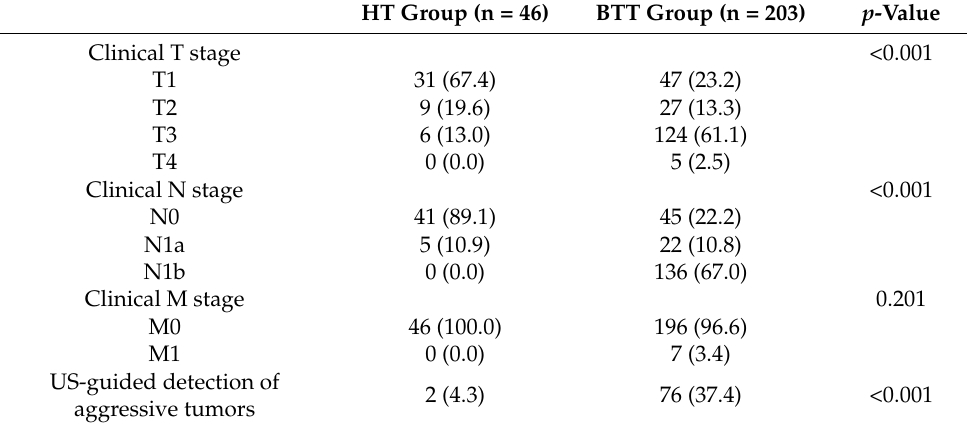
Table 2. Comparison of preoperative imaging findings for clinical TNM stage and detection of aggressiveness between patients who underwent HT and BTT. HT Group (n = 46) BTT Group (n =